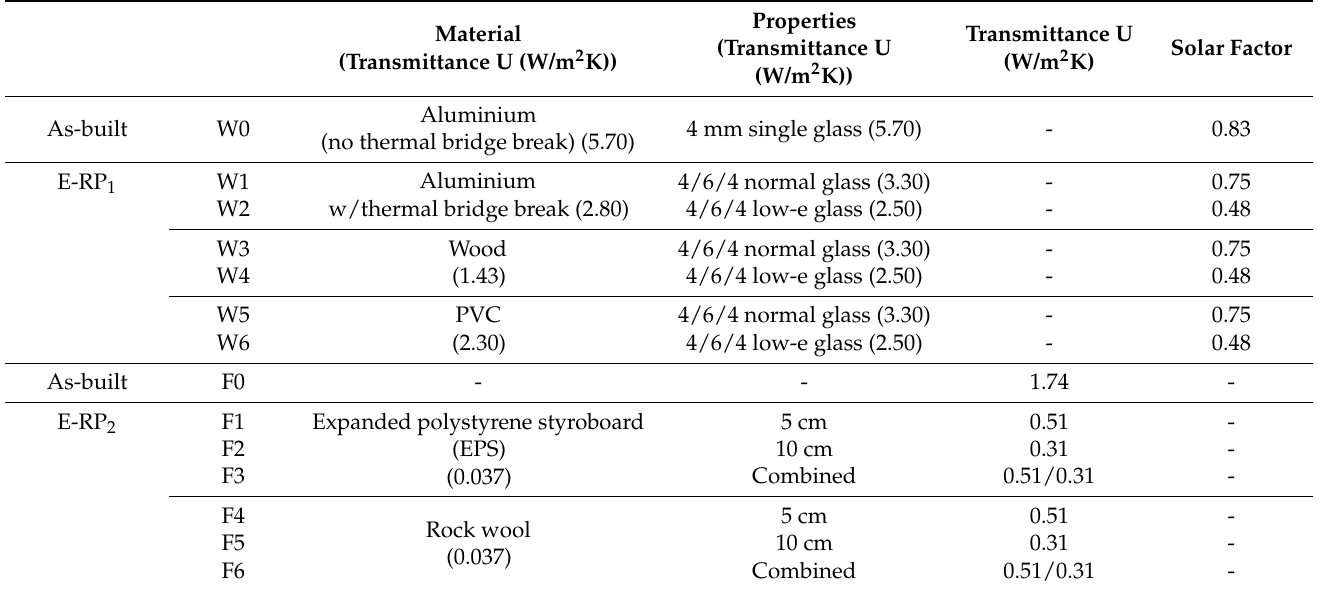
Table 7. Models analysed in the sensitivity analysis of the energy